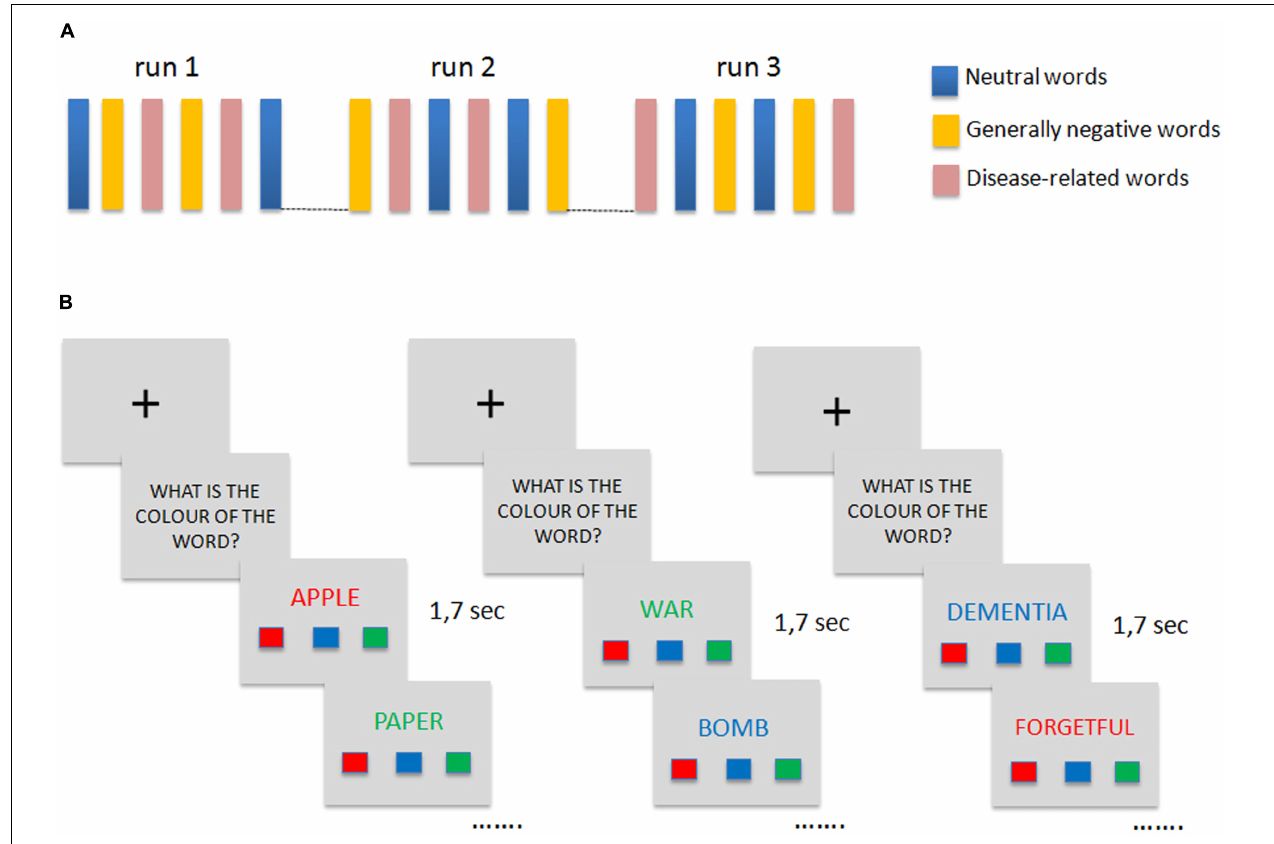
FIGURE 1 | Emotional Stroop fMRI paradigm. (A) Graphical representation of the block-design protocol paradigm. (B) Examples of stimuli used in the experiment for each group of words (from left to right: neutral words, negative words, dementia-related words) and order of presentation within the block.